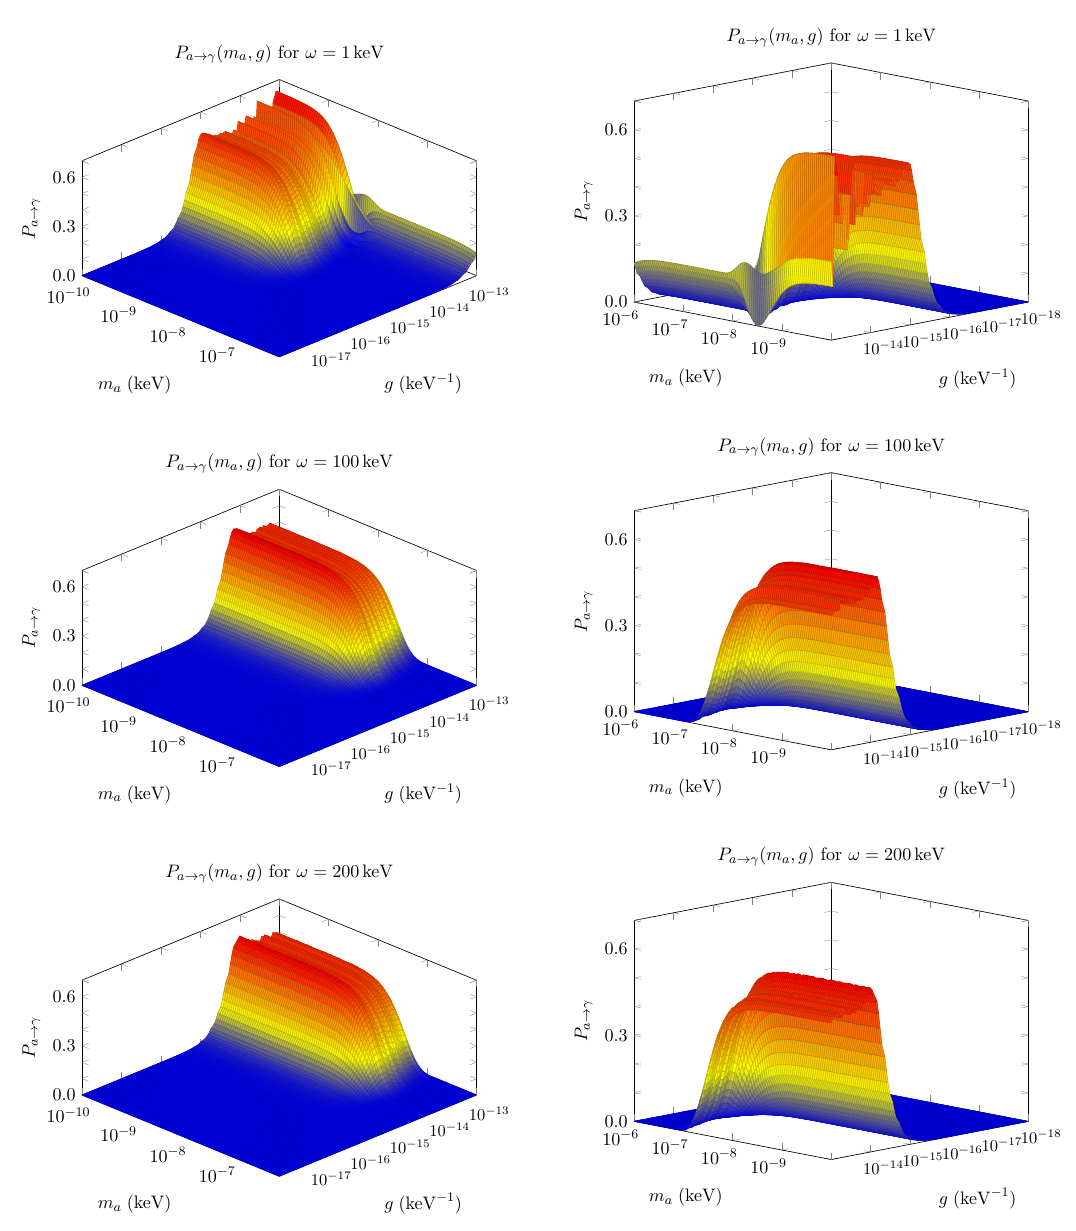
Figure 3 . ALP-to-photon conversion probability in the ( m a ; g ) plane for di(cid:11)erent values of the ALP energy ! corresponding to ! = 1 keV (top panels), ! = 100 keV (middle panels) and ! = 200 keV (bottom panels). The two panels (left and right) show the same conversion probability from di(cid:11)erent points of view.